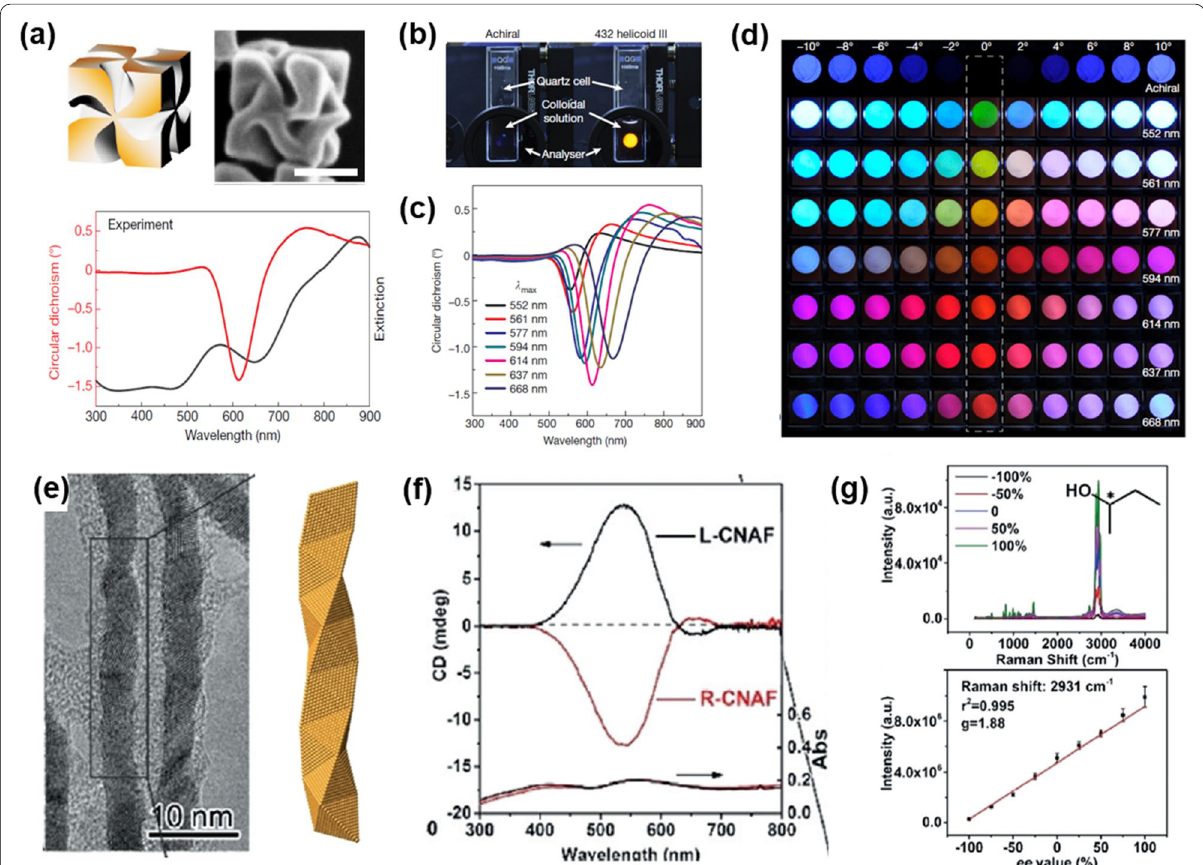
Fig. 10 a 3D-model (left), corresponding scanning electron microscope (SEM) image (right), and circular dichroism and extinction spectra of 432 helicoid III. Scale bar, 100 nm. b Photographs of cross-polarized transmission of achiral (left) and 432 helicoid III (right) solutions. c CD spectra of seven 432 helicoid III dispersions having different λ max values corresponding to the wavelength of maximum g-factor. d Polarization-resolved transmission colors of achiral nanoparticle (first row) and seven 432 helicoid III dispersions. Reproduced with permission from [72]. Copyright 2018. Nature Publishing Group. e TEM image of Au nanofibers with twisted morphologies (left) and representation of a right-handed chiral Au fiber with BCB helix structure. f Circular dichroism and absorption spectra of l - and R-chiral nanostructures Au films. g Raman spectra (top) and dependencies (bottom) of the largest SERS peak areas on ee values from 100% to 100% for 2-butanol, showing SERS-ChA effect of R-CNAFs. Reproduced with − + permission from [73]. Copyright 2020